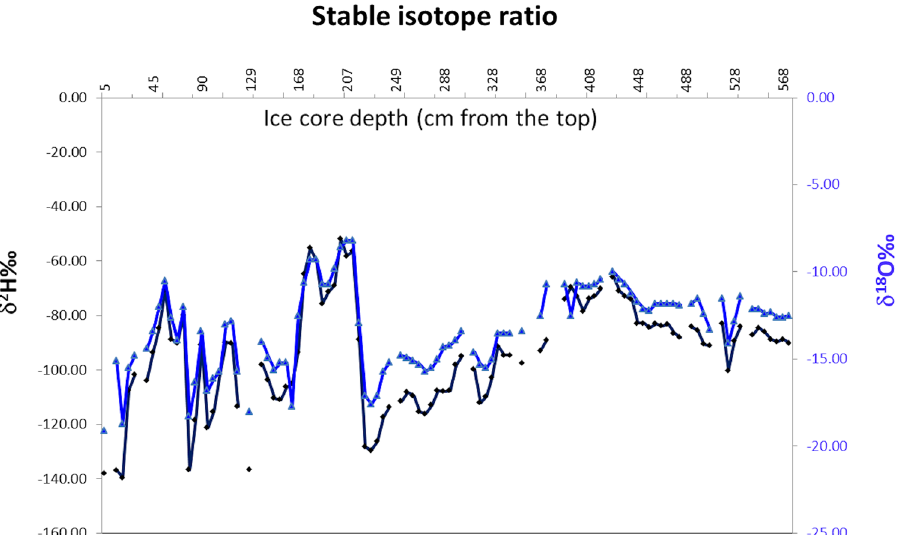
Figure 2. Stable isotope ratio. Values of δ 18 O‰ (in blue) and δ 2 H‰ (in black) concentration measured along the depth of the